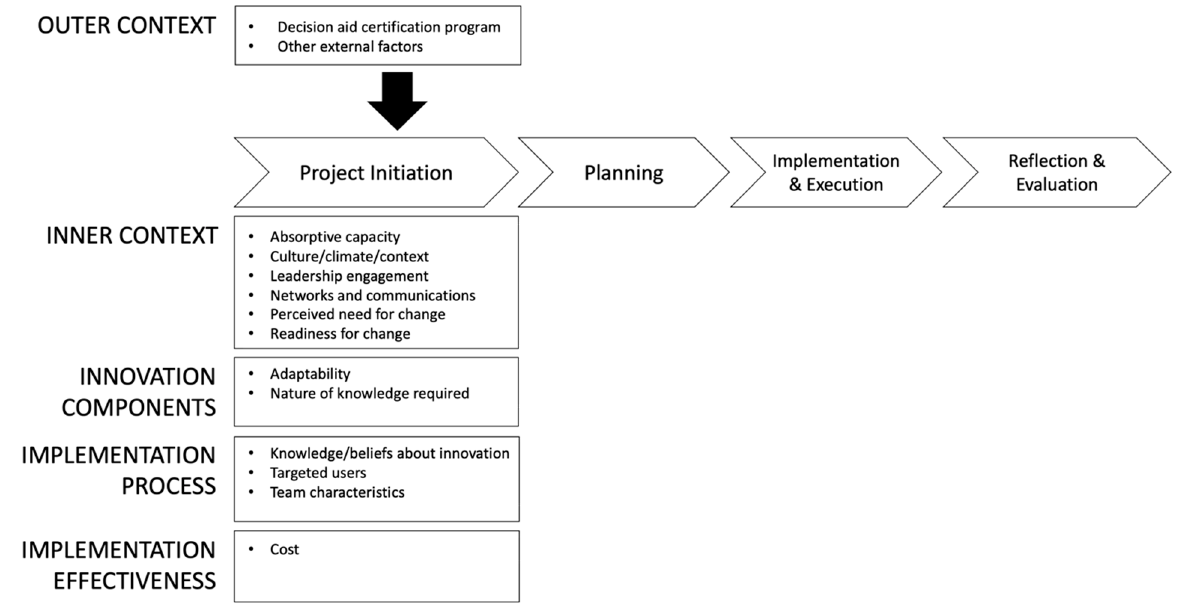
Figure 1. Conceptual model; note—Model draws upon [17–19].